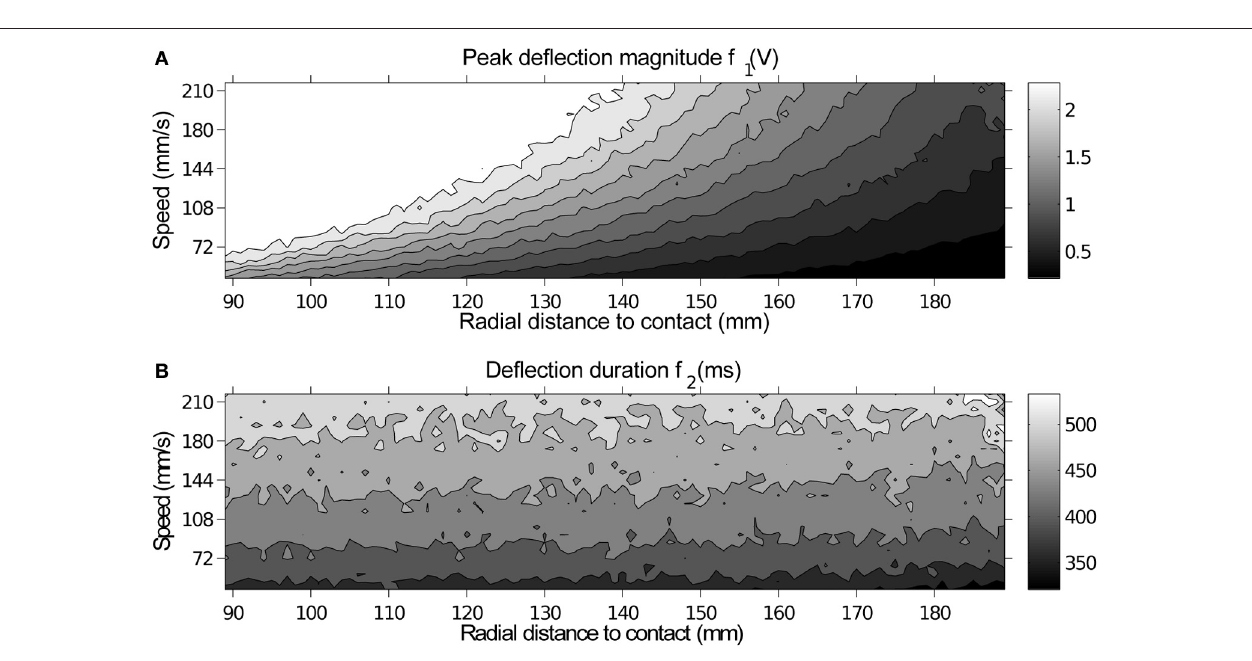
deflection magnitude f 1 , brightness indicates higher deflection magnitude, measured in volts. All 10 contours are evenly spaced across the voltage range. (B) Deflection duration f 2 , brightness indicates greater duration (measured in ms). All 6 contours are evenly spaced across the duration